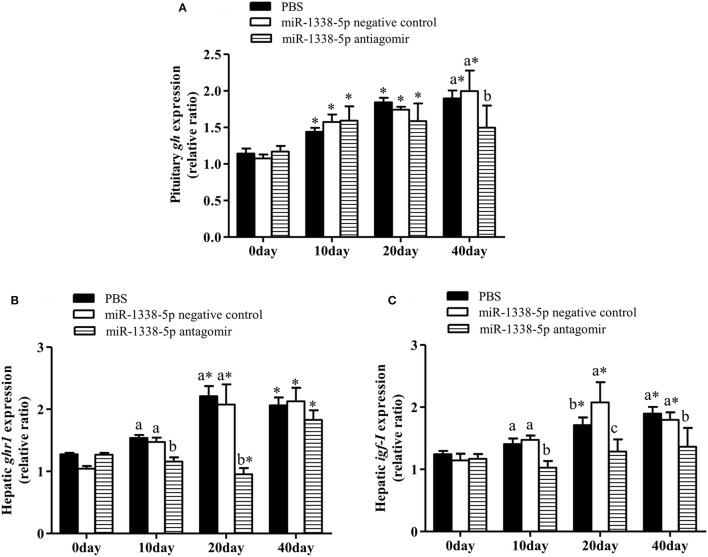
Effect of inhibiting miR-1338-5p on the expression of gh, ghr, and igf-I in pituitary or liver of GIFT over 40 days time period. Juvenile GIFT weighing about 5.8 g received a tail-vein injection of PBS, miR-1338-5p negative control, or miR-1338-5p antagomir at a dose of 50 mg kg−1 body weight. The antagomir was injected once every 6 days. qRT-PCR analysis was used to detect the relative expression of gh
(A), ghr1
(B), and igf-I
(C) (n = 9–12 fish per group). The GIFTs injected with PBS were taken as the control. *P < 0.05 indicates significant differences between values of each treatment obtained before and after injection by paired-samples t-test. Diverse lowercase letters show significant differences (P < 0.05) in different treatments of each sampling point by Duncan's multiple range test. Fold changes in expression levels were normalized against the pre-treatment sampling point of PBS group.